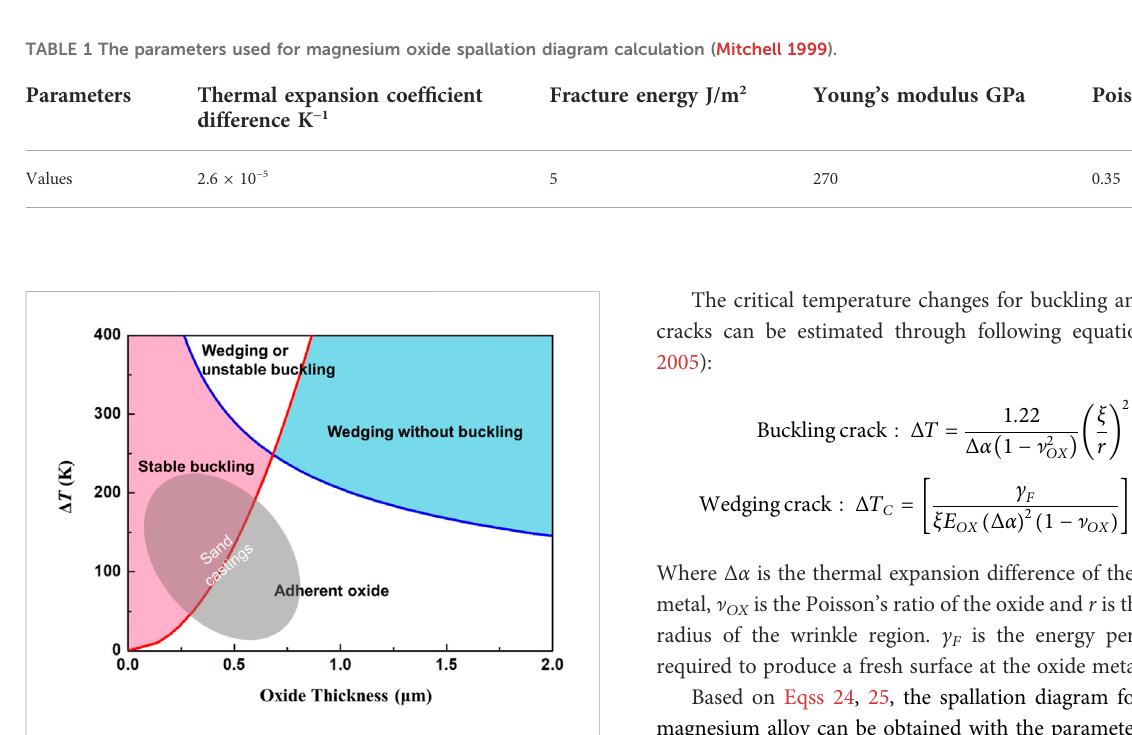
FIGURE 12 The spallation diagram for MgO on magnesium